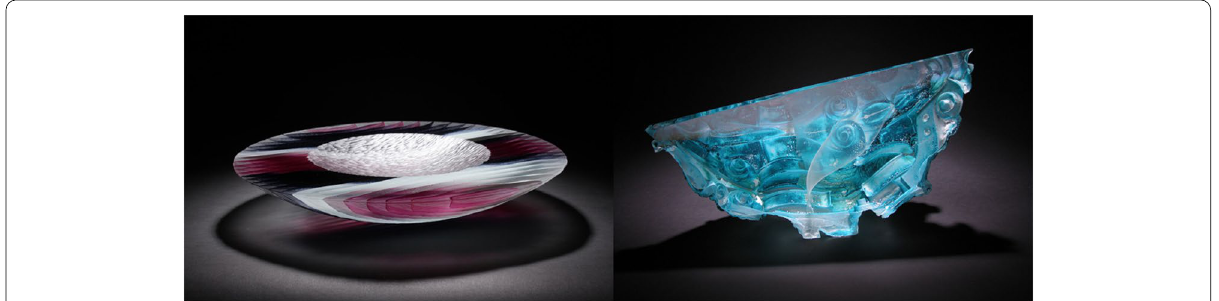
Fig. 37 Two artworks created by Colin Reid. He is good at making various works of art using